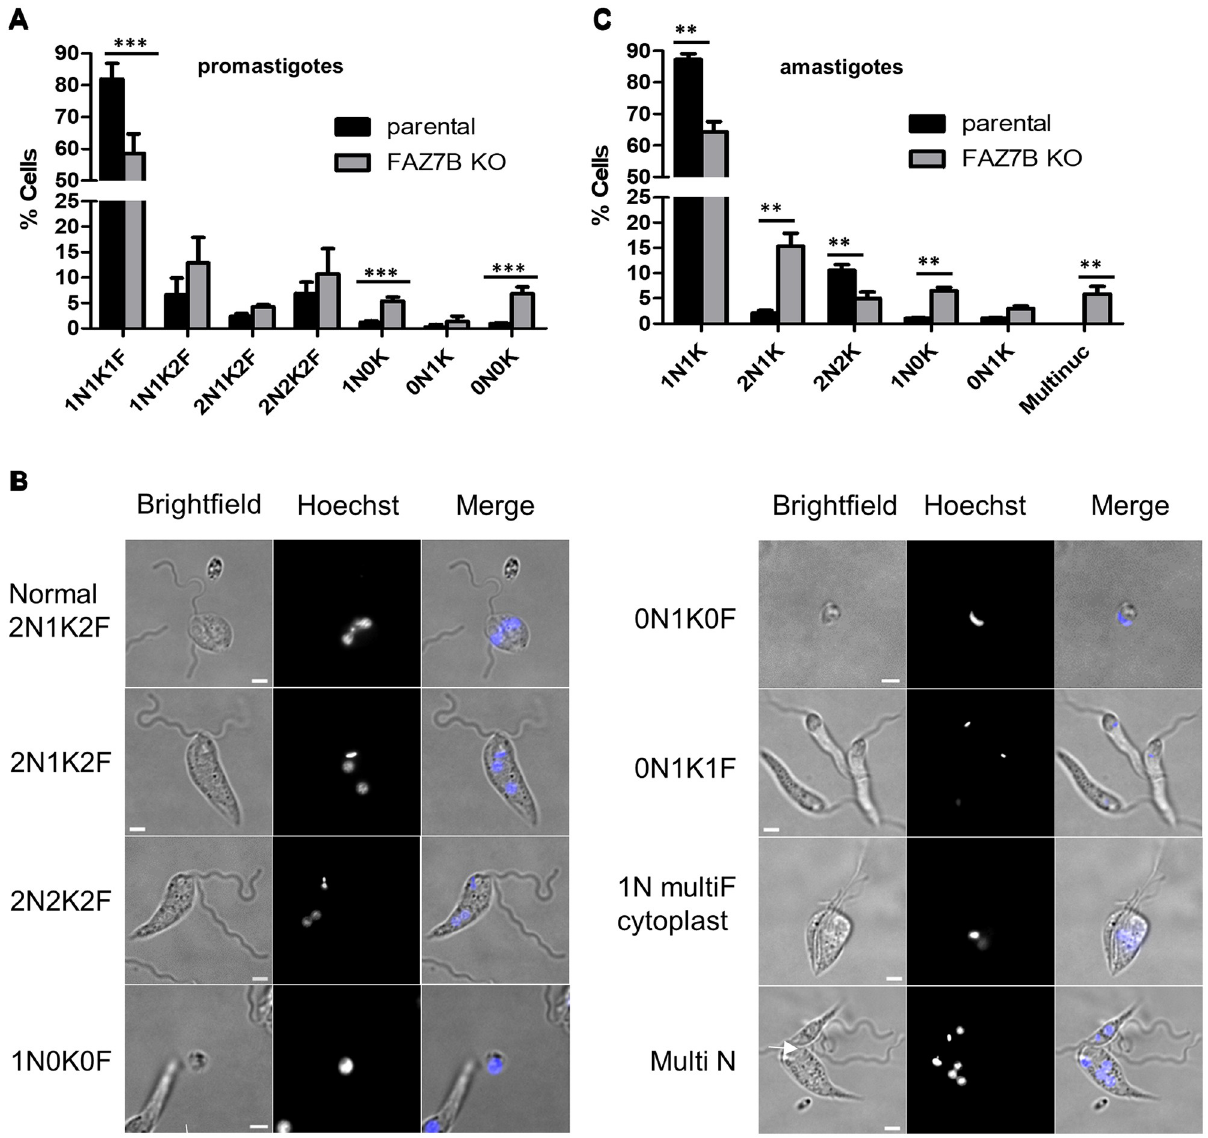
Fig 3. Deletion of FAZ7B impairs cell division in promastigotes and amastigotes. (A and C) Quantification of nuclei (N) and kinetoplasts (K) cell phenotypes in DAPI-stained parental and FAZ7B KO cell lines: (A) Promastigotes, (C) Axenic amastigotes. Error bars represent SDs calculated from three independent experiments (n = 300). �� p < 0.01, � p < 0.05 (Student’s t-test). (B) Examples of dividing cells in the promastigote FAZ7B KO cell line, Hoechst-stained after 14hs of time-lapse imaging, showing the indicated categories of N/K patterns; multiF: multiflagellated cell; MultiN: a cell with several nuclei and kinetoplasts; cytoplasts can be seen, with (1N0K0F and 0N1K0F) or without (left panel, top) DNA, as well as in a dividing process (1N multiF cytoplast). See also S5, S6 and S7 Movies. Scale bar: 5 μ m.